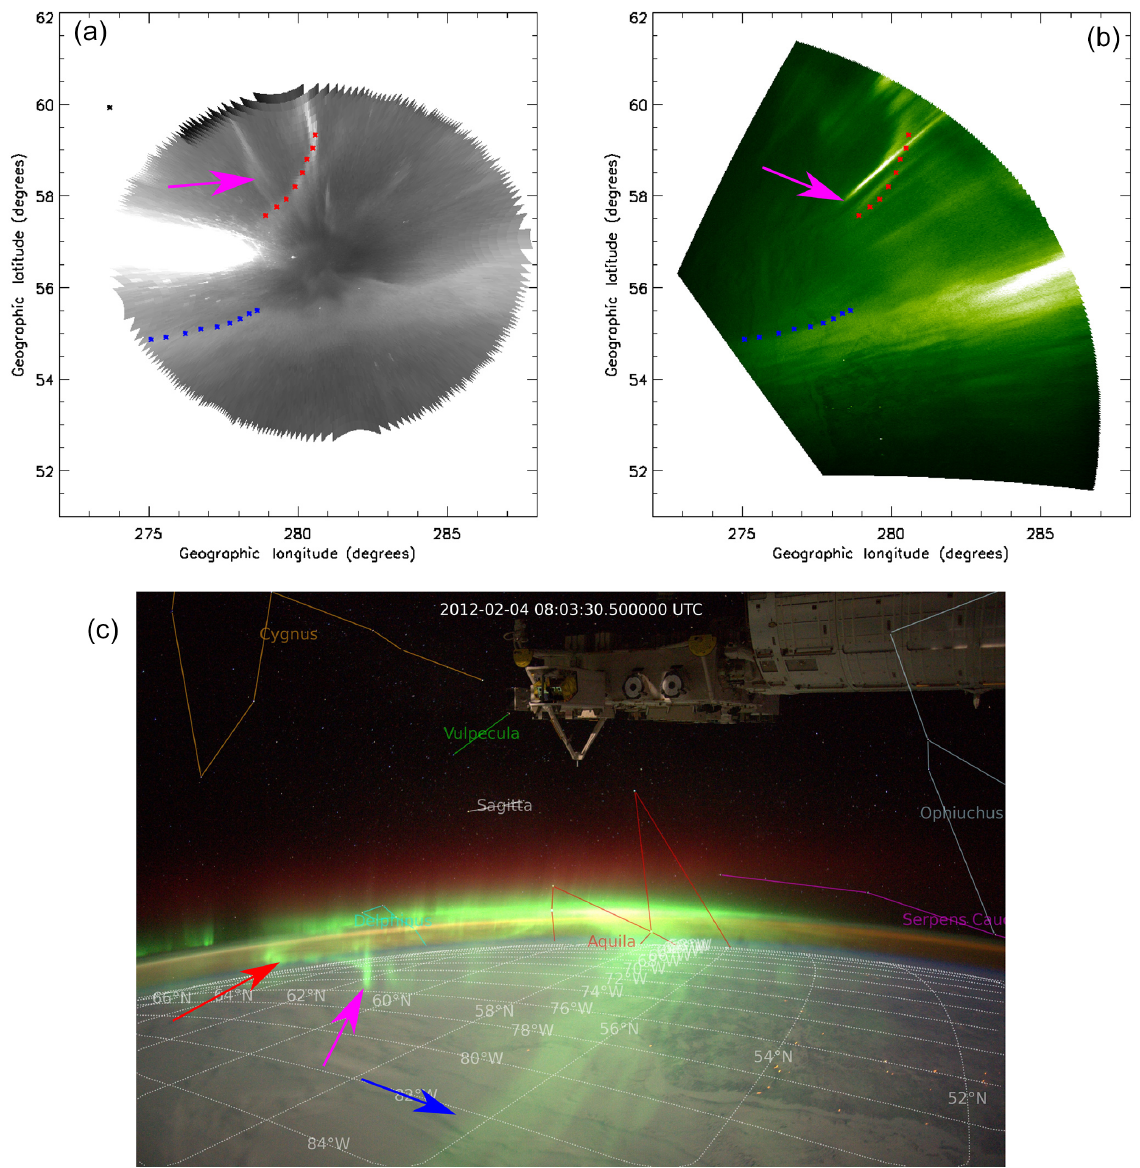
Figure 12. A more detailed comparison between the ISS image plotted in Fig. 11 (b) and the contemporaneous image acquired by the SNKQ THEMIS ASI (a) . The original ISS image is plotted in (c) . Red and blue symbols trace the locations of the j shaped arc and northern edge of the main auroral arc, respectively, derived from their locations in the THEMIS image. The features are marked with the same coloured arrows in (c) . The magenta arrows point out a vertical feature projected very differently in (a) and (b)